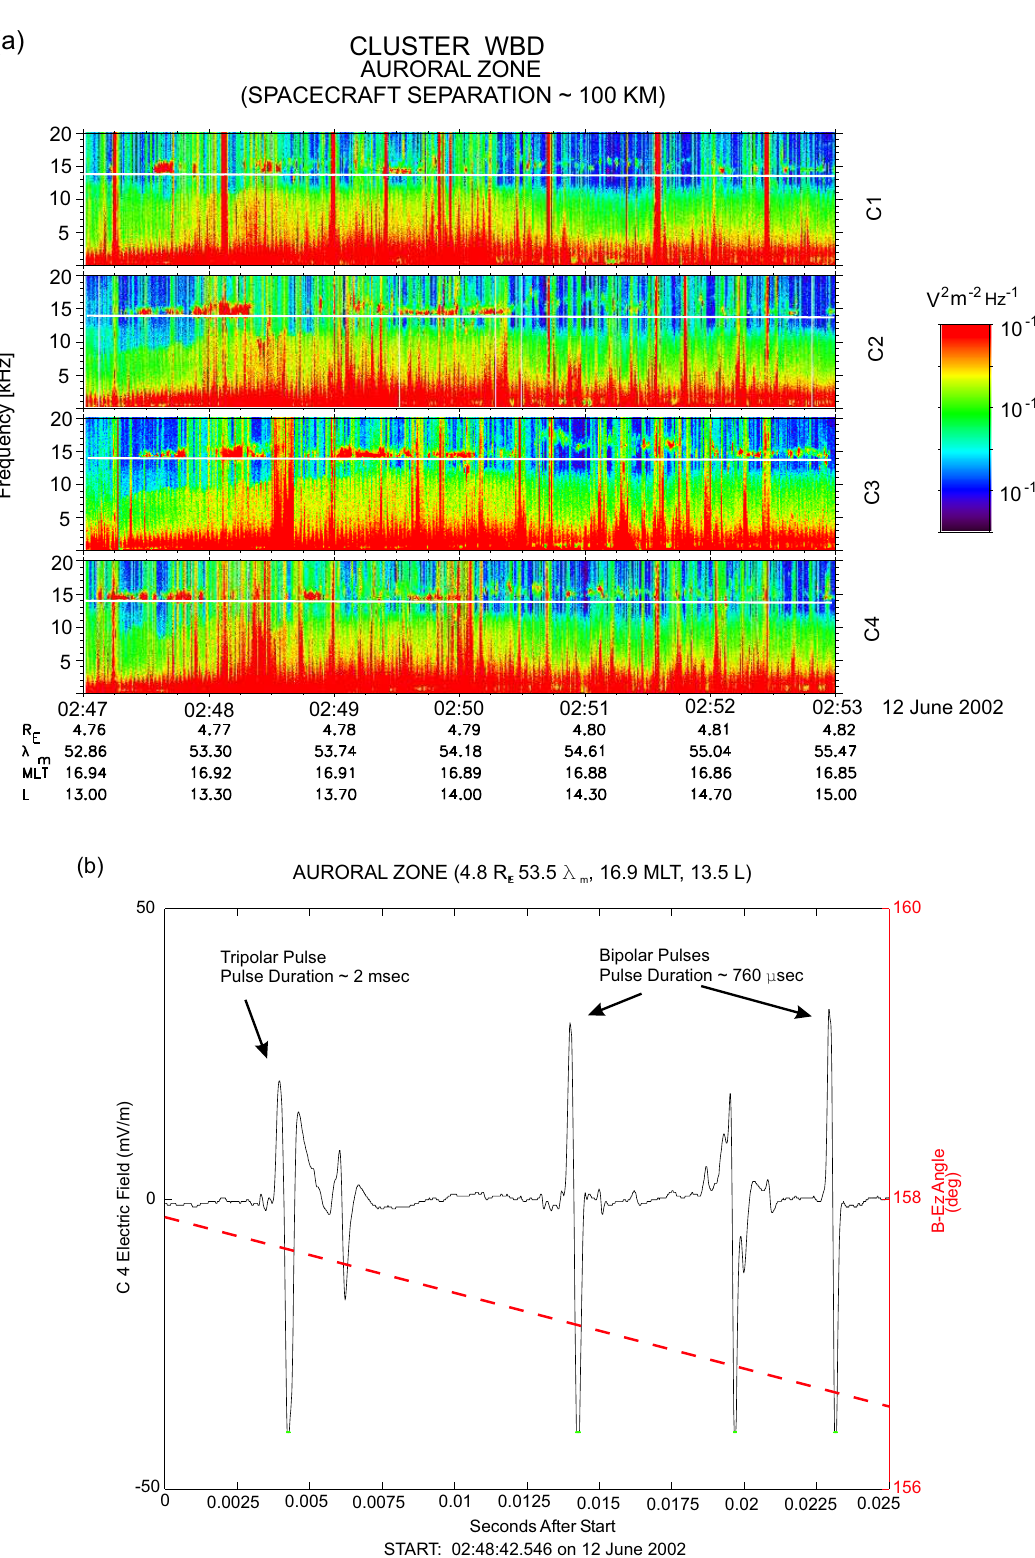
Fig. 1. Cluster WBD data taken on 12 June 2002 in the auroral zone. ( a ) Spectrogram showing the frequency and power spectral density of the emissions. The broad-band signals ranging up to about 10kHz are indicative of times when IES are observed. ( b ) Representative waveform from a time of the broad-band signals, showing the two types of IES: bipolar and tripolar